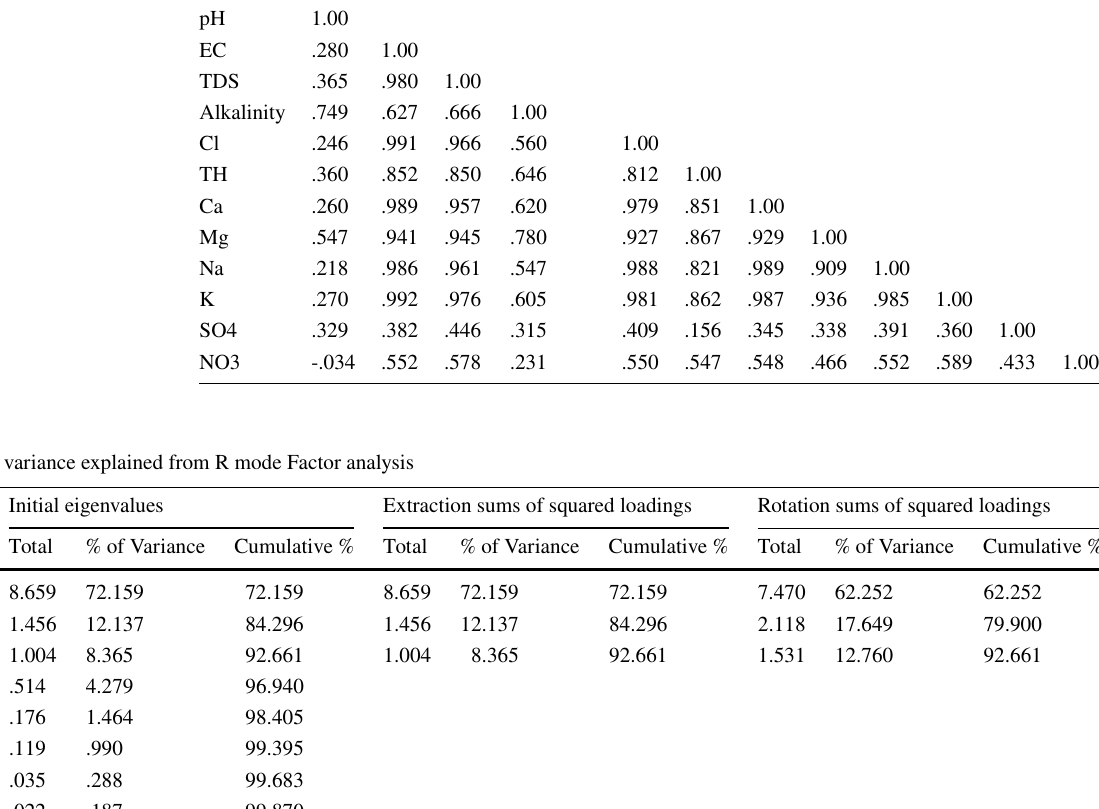
Table 7 Statistical correlation between parameters